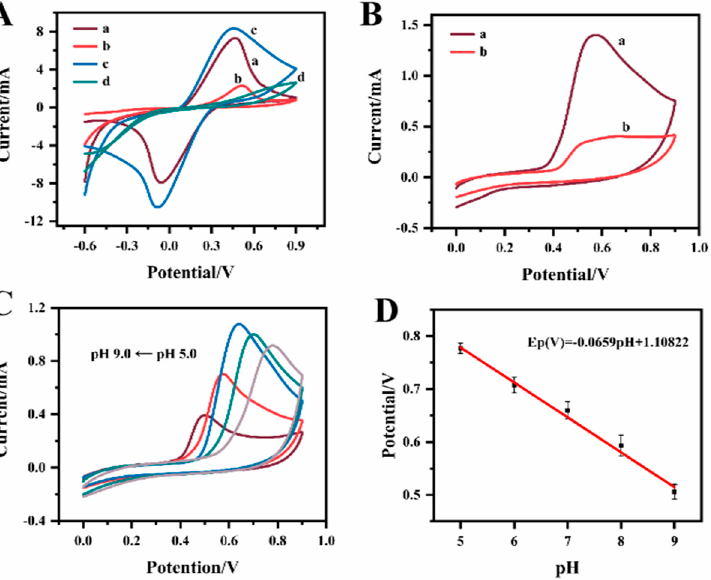
Figure 5. ( A ) CV responses of bare CF (a), BPA–MIP@CF (b), MIP@CF (c) and NIP@CF (d) in